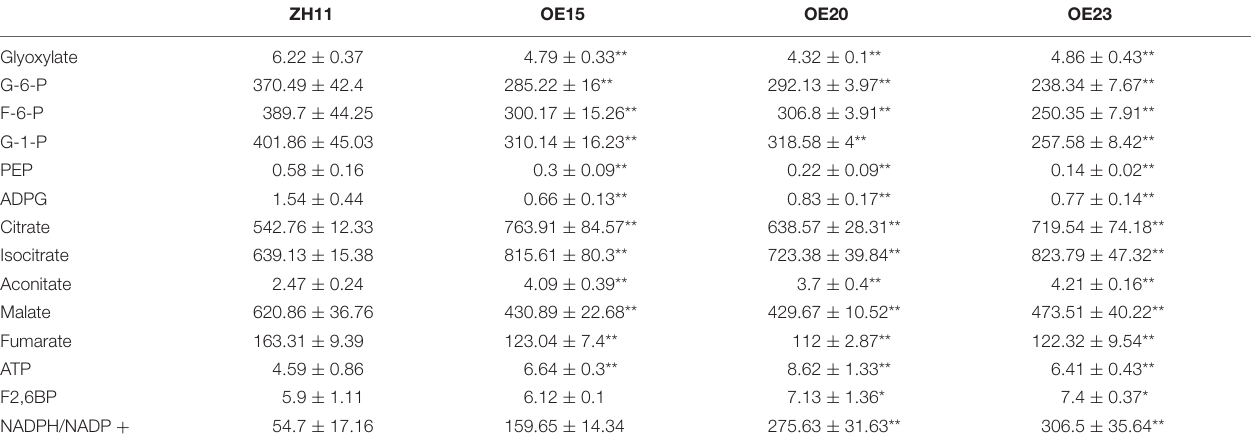
Values were means ± SD of 3 biological replications. The unit of measurement is nmol g − 1 (FW). Statistical significance was determined by Student’s t-test (*P < 0.05; **P < 0.01). ND: not detect.